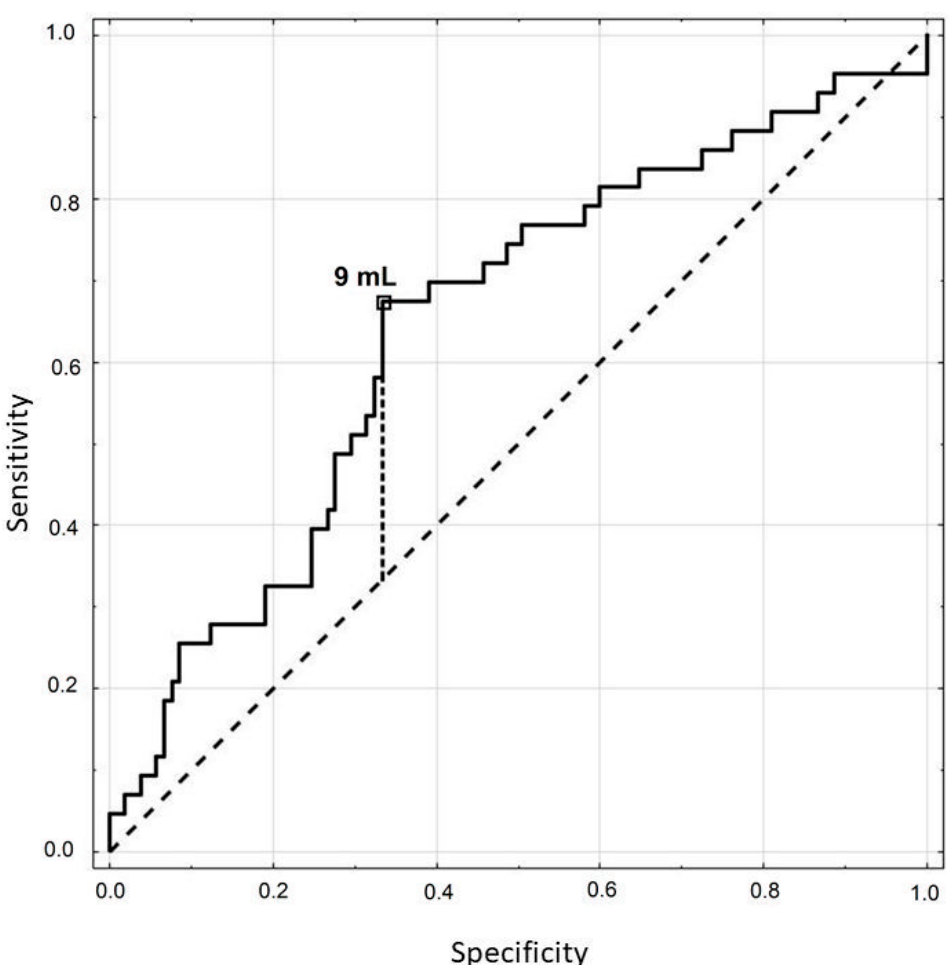
Figure 2. ROC curve for the thyroid volume in estimating if thyrotropin (TSH) is above 2.5 µIU/mL.